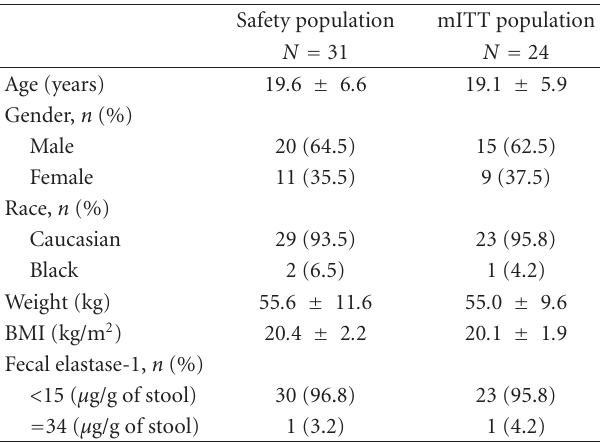
Table 1: Baseline characteristics of study